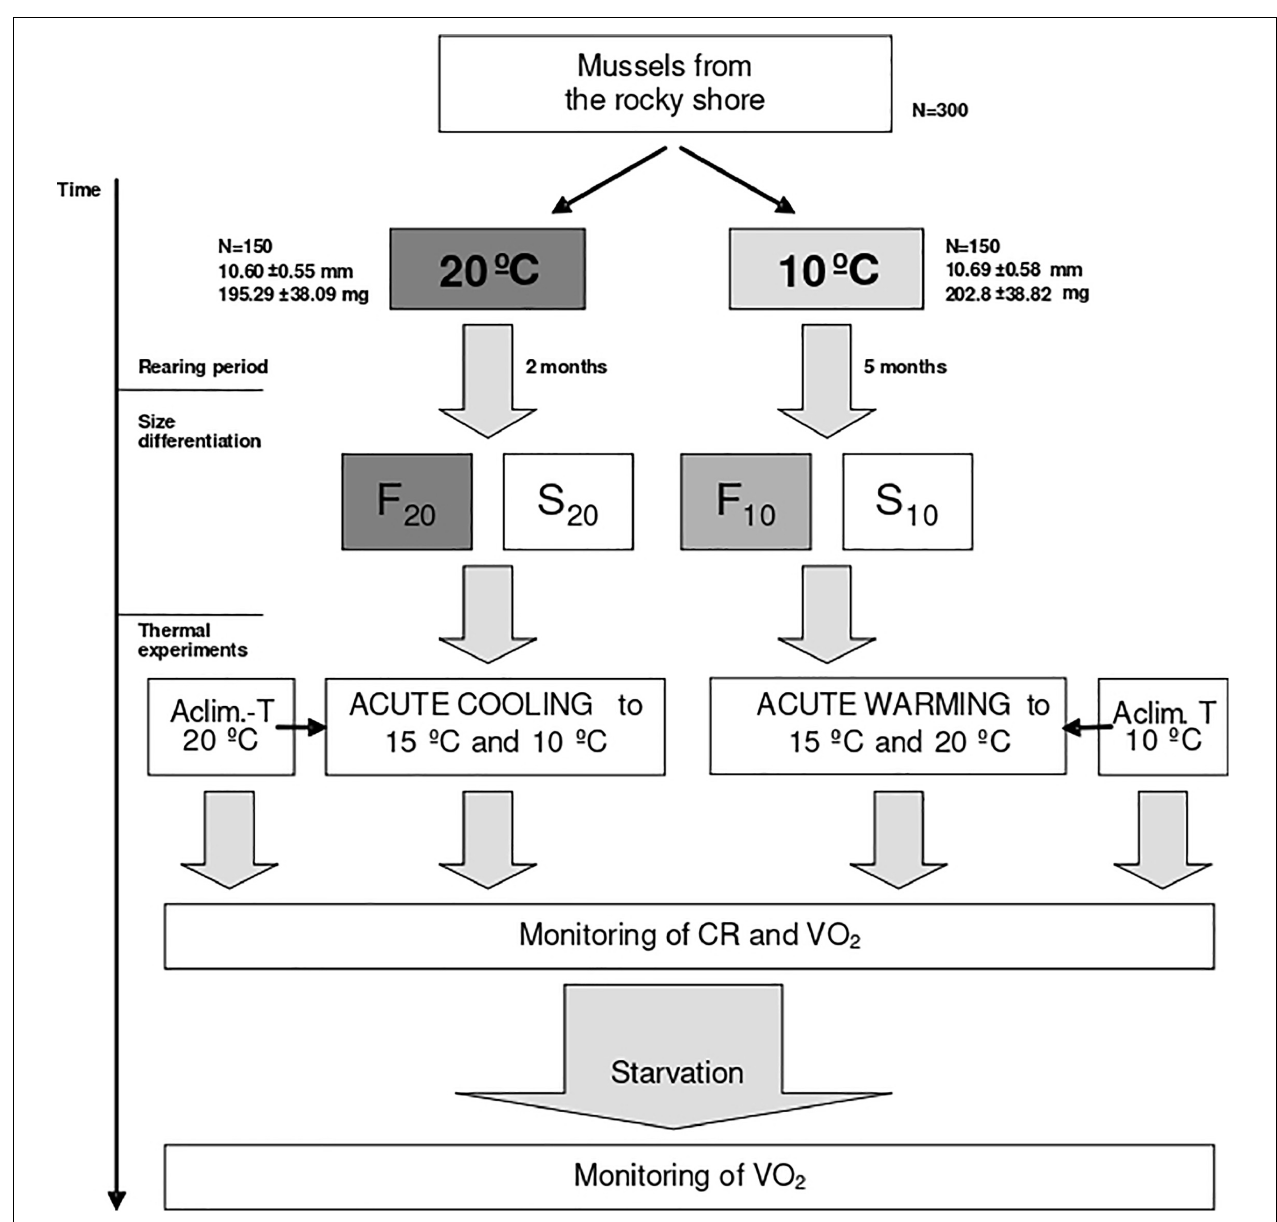
FIGURE 1 | Experimental